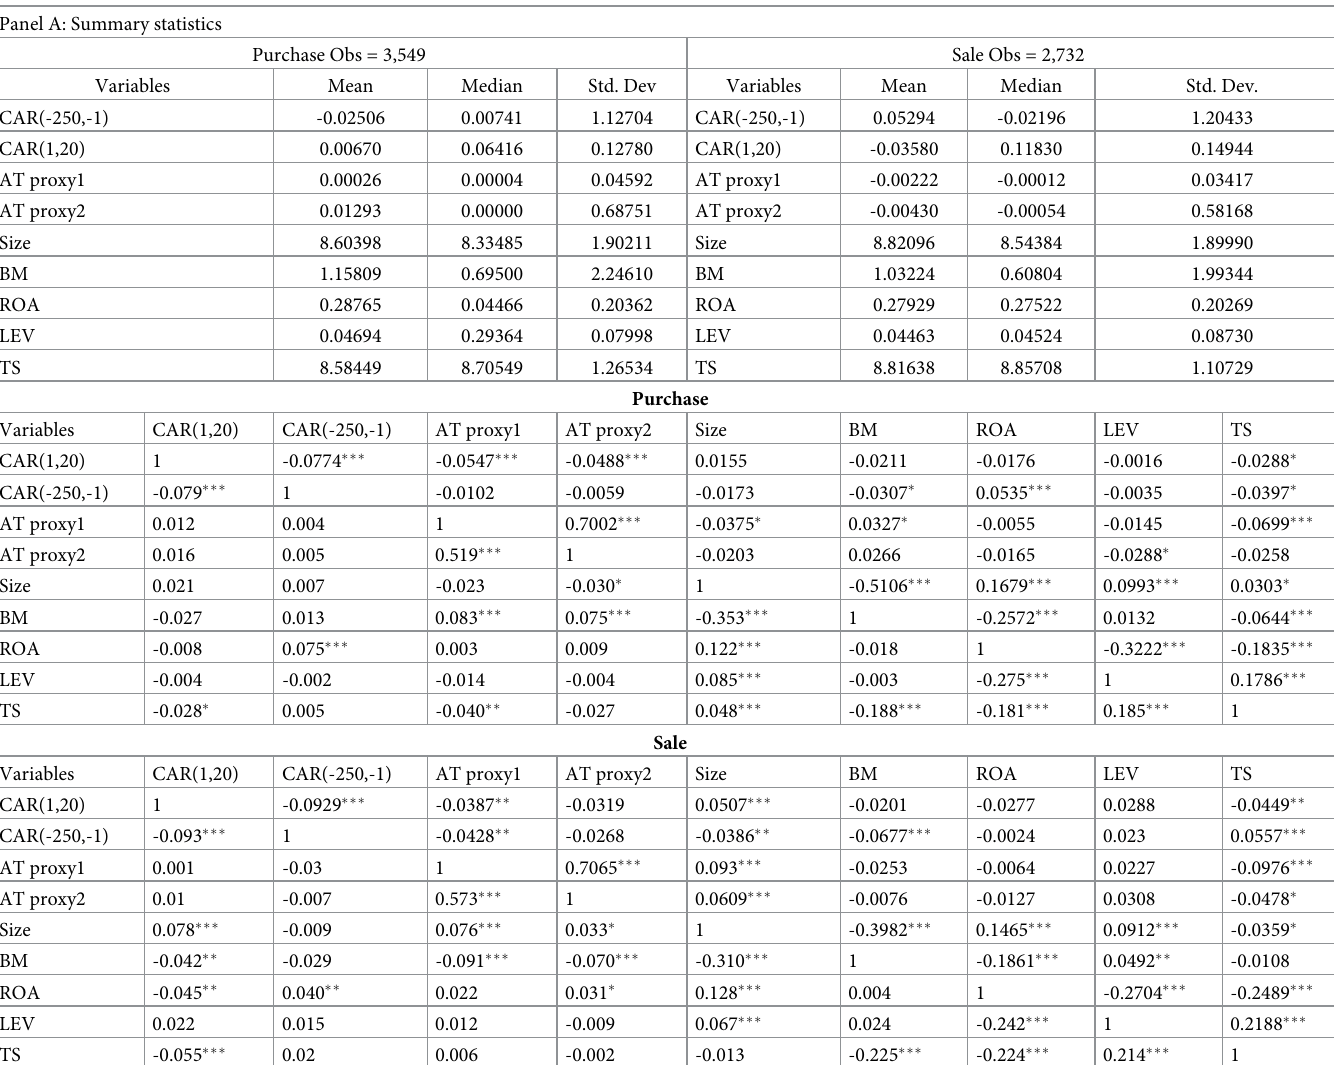
Table 1. Summary